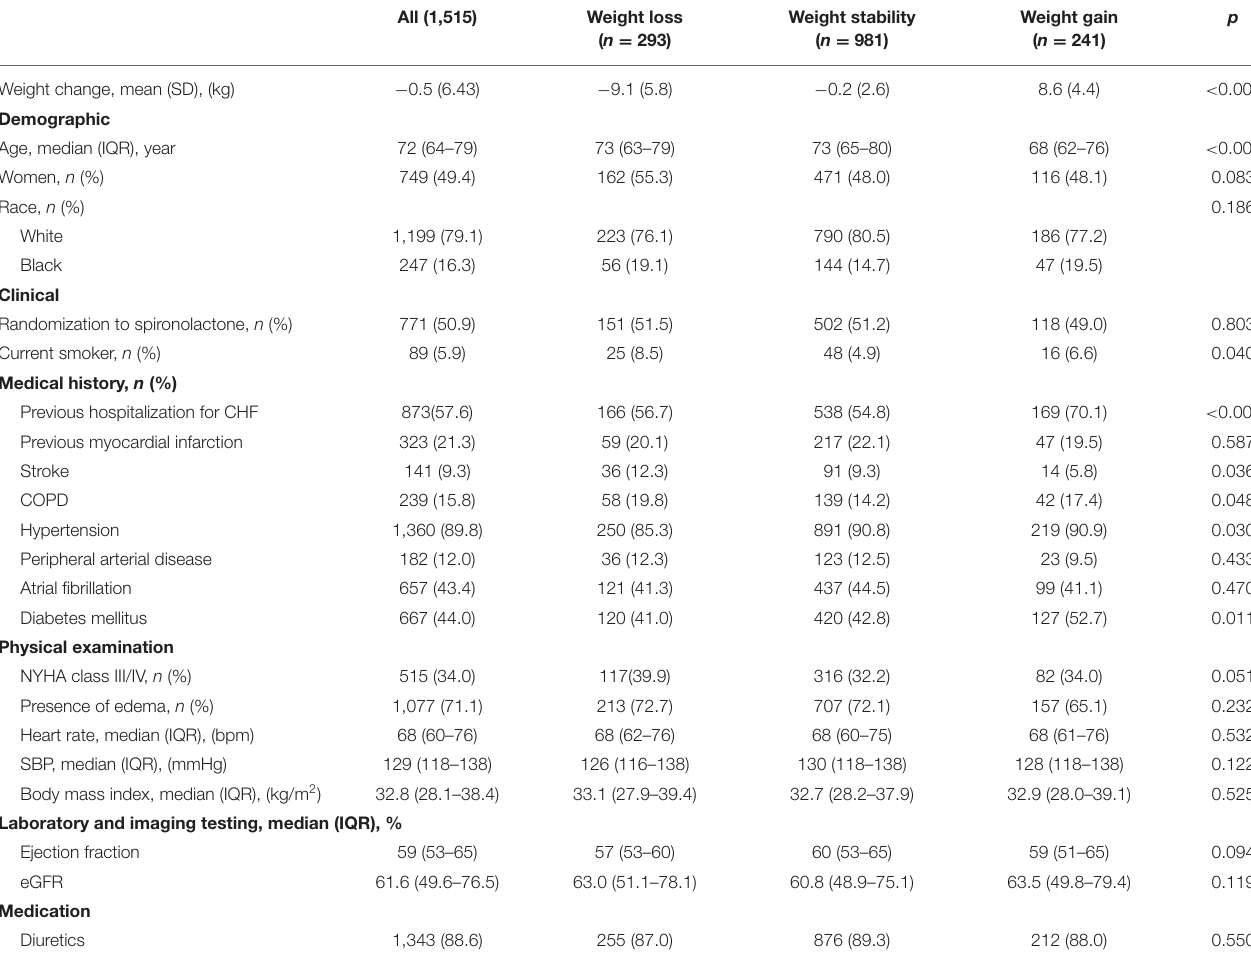
TABLE 1 | Baseline demographic and clinical characteristics by weight change groups.